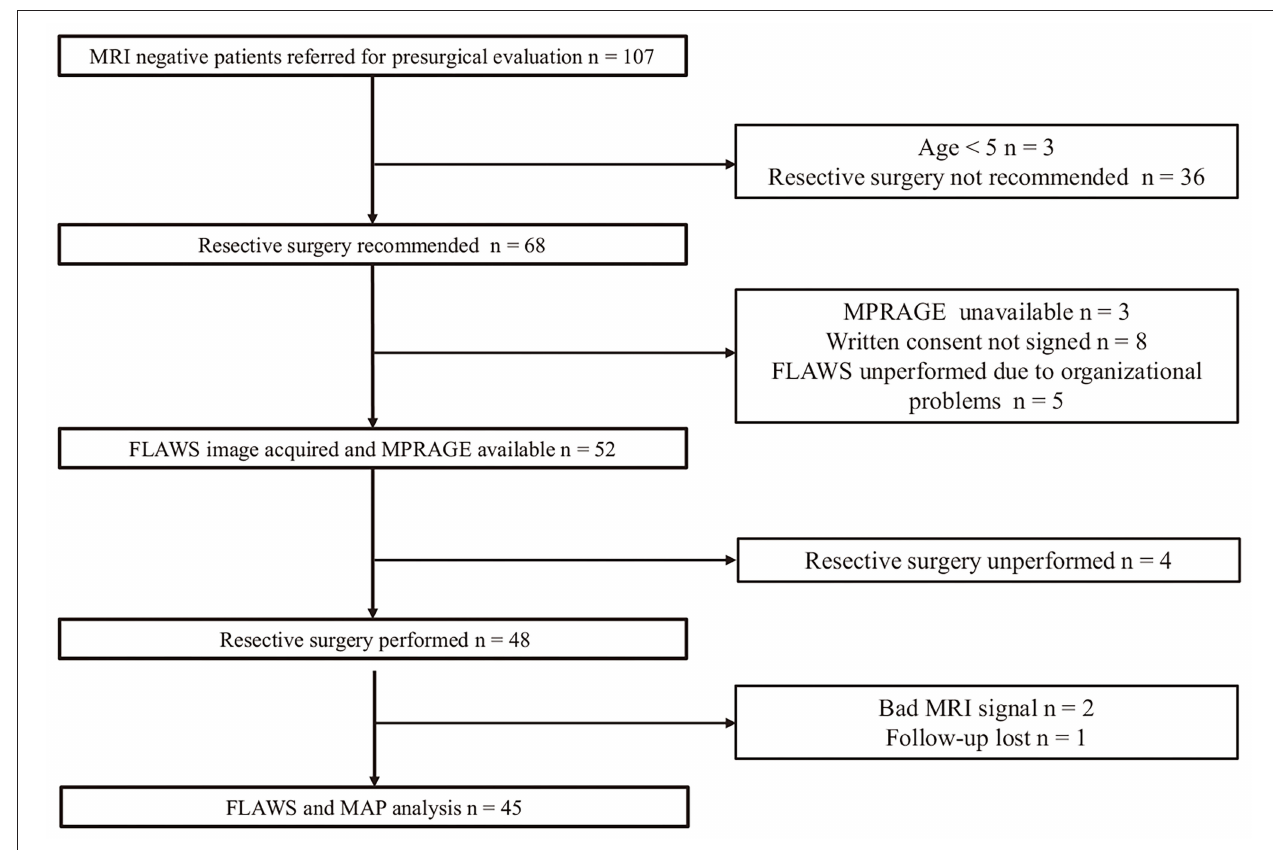
FIGURE 1 | Flowchart of patient enrollment. FLAWS unperformed due to organizational problems: the time between presurgical evaluation and invasive implantation or resective surgery was too close to allow for a FLAWS scan.